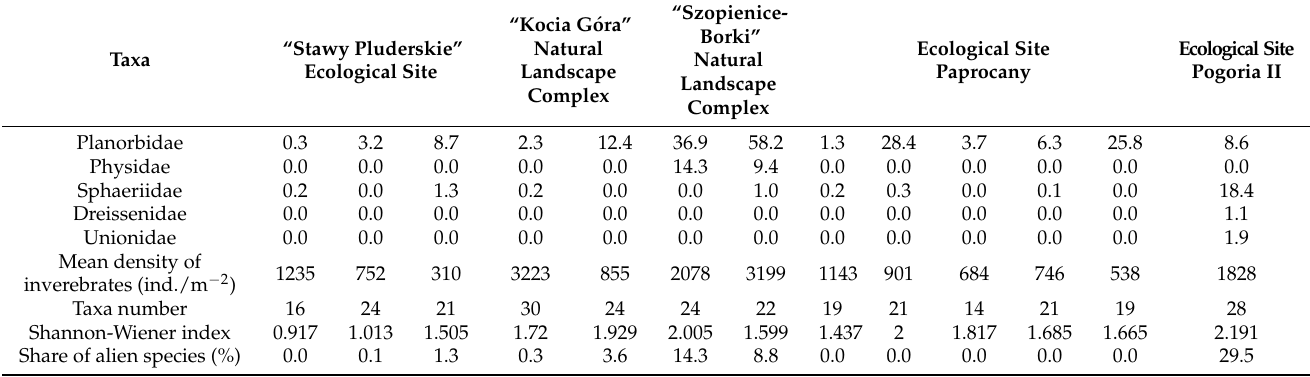
formed one distinctive group (Figure 2).